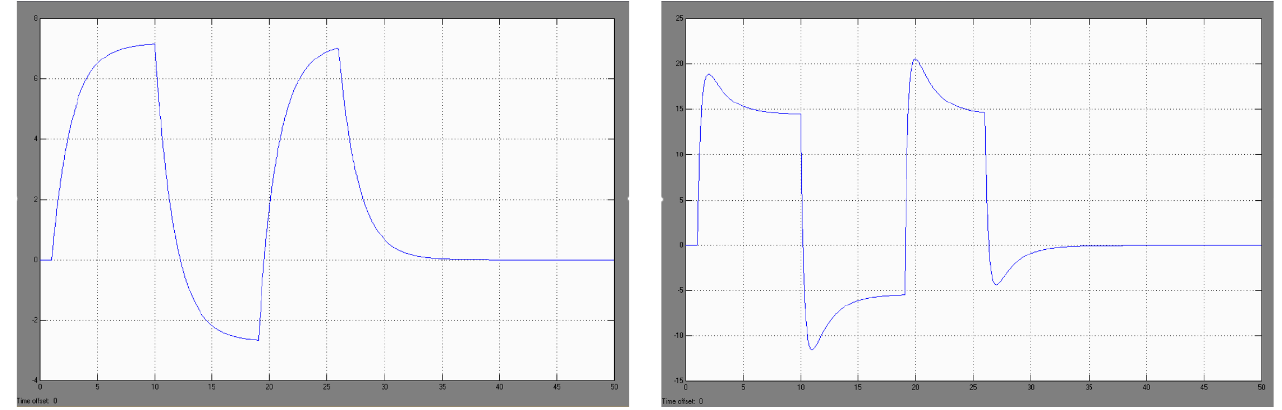
Figure 9. Modeled waveforms of the thermoelectric sensor signal after its sudden heating and cooling during heating for the DPS sensor ( left ) and for the DTBG sensor ( right ).